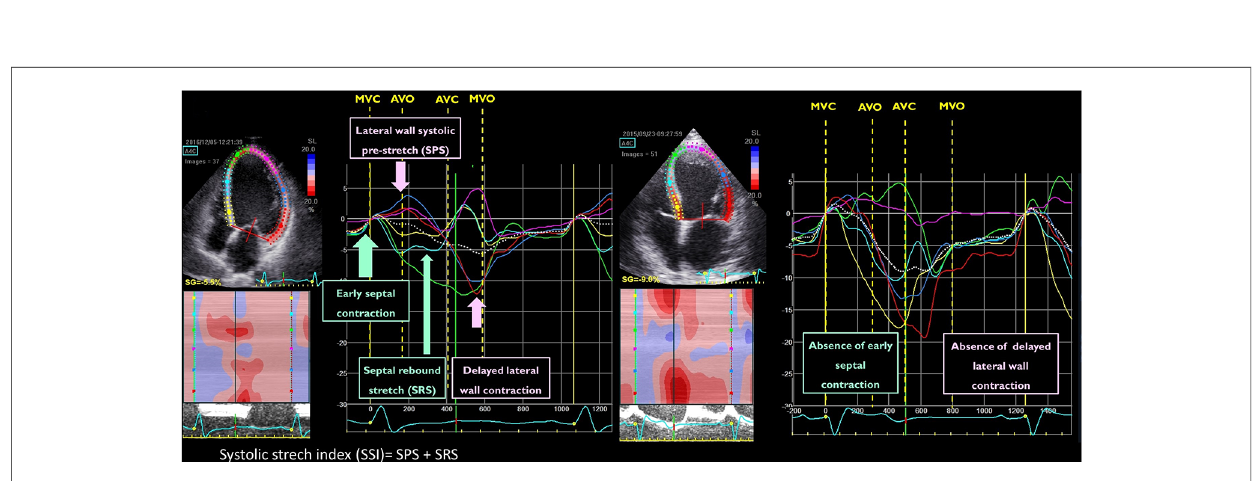
FIGURE 3 Example of the qualitative analysis of strain curves in a patient with a “ typical ” left bundle branch block (left panel) and “ atypical ” left bundle branch block (right panel). The systolic stretch index (SSI) quanti fi cation is exempli fi ed in the same picture (left